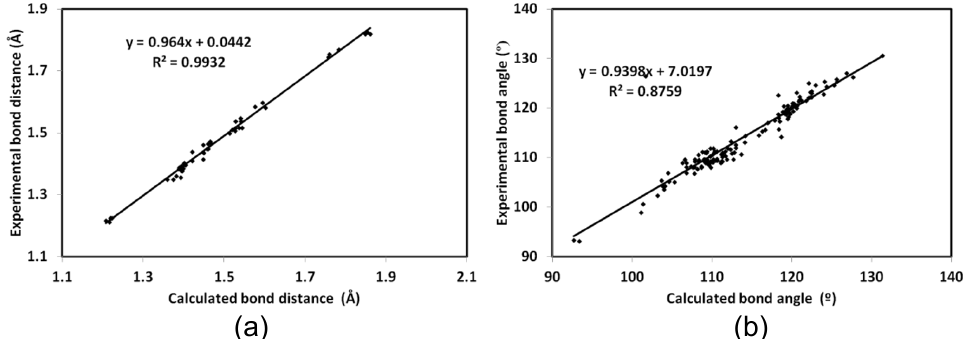
Figure 7. Correlations between the calculated and experimental ( a ) bond distances, and ( b ) bond angles.